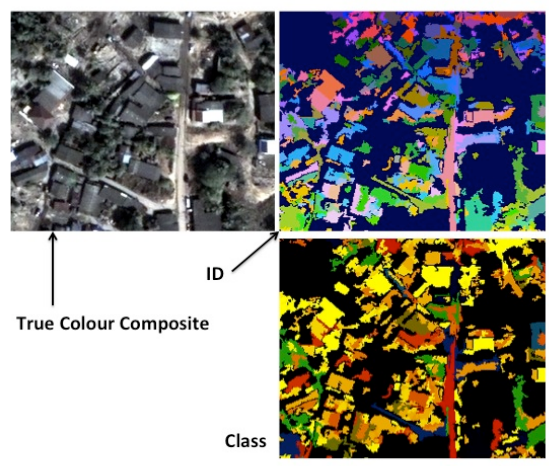
Figure 6. Fine level processing results of a non-damage area